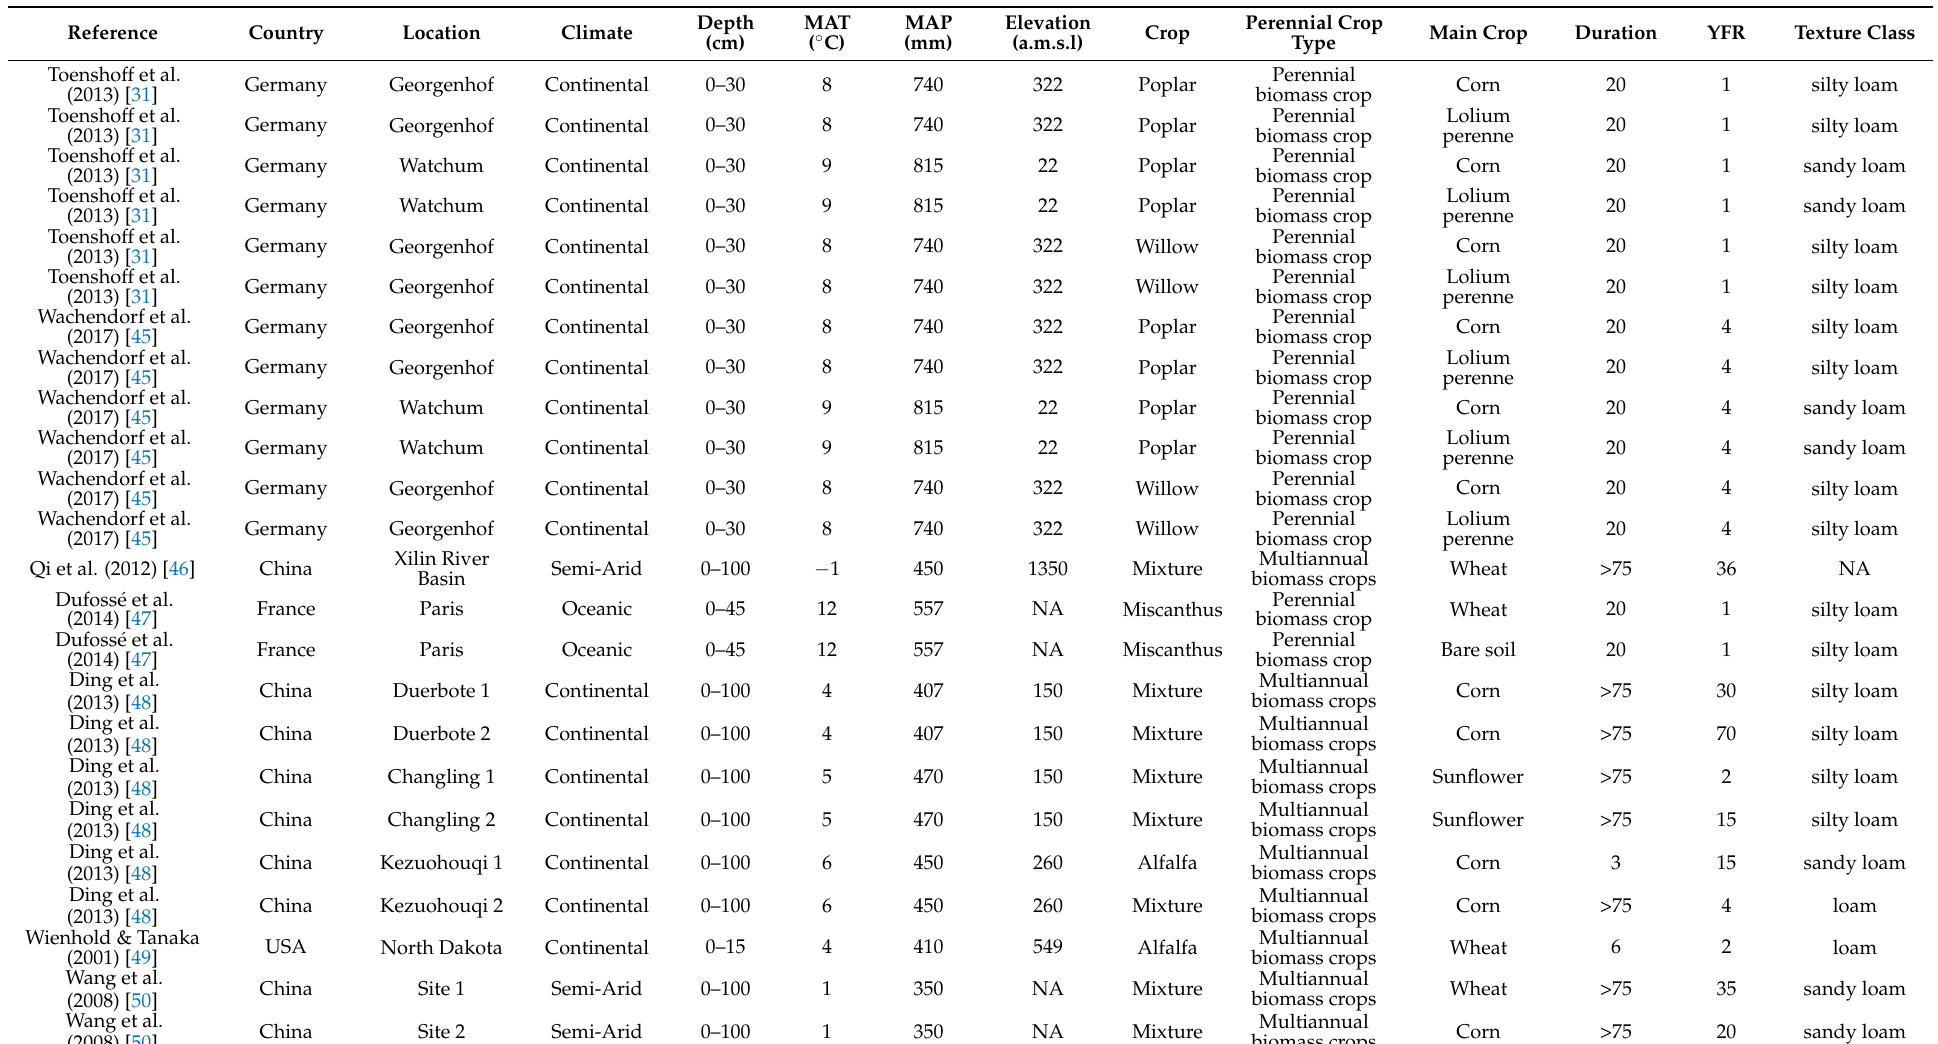
Table 2. Summary of data for the studies in the meta-analysis on the effect of perennial crop reversion on soil C and N